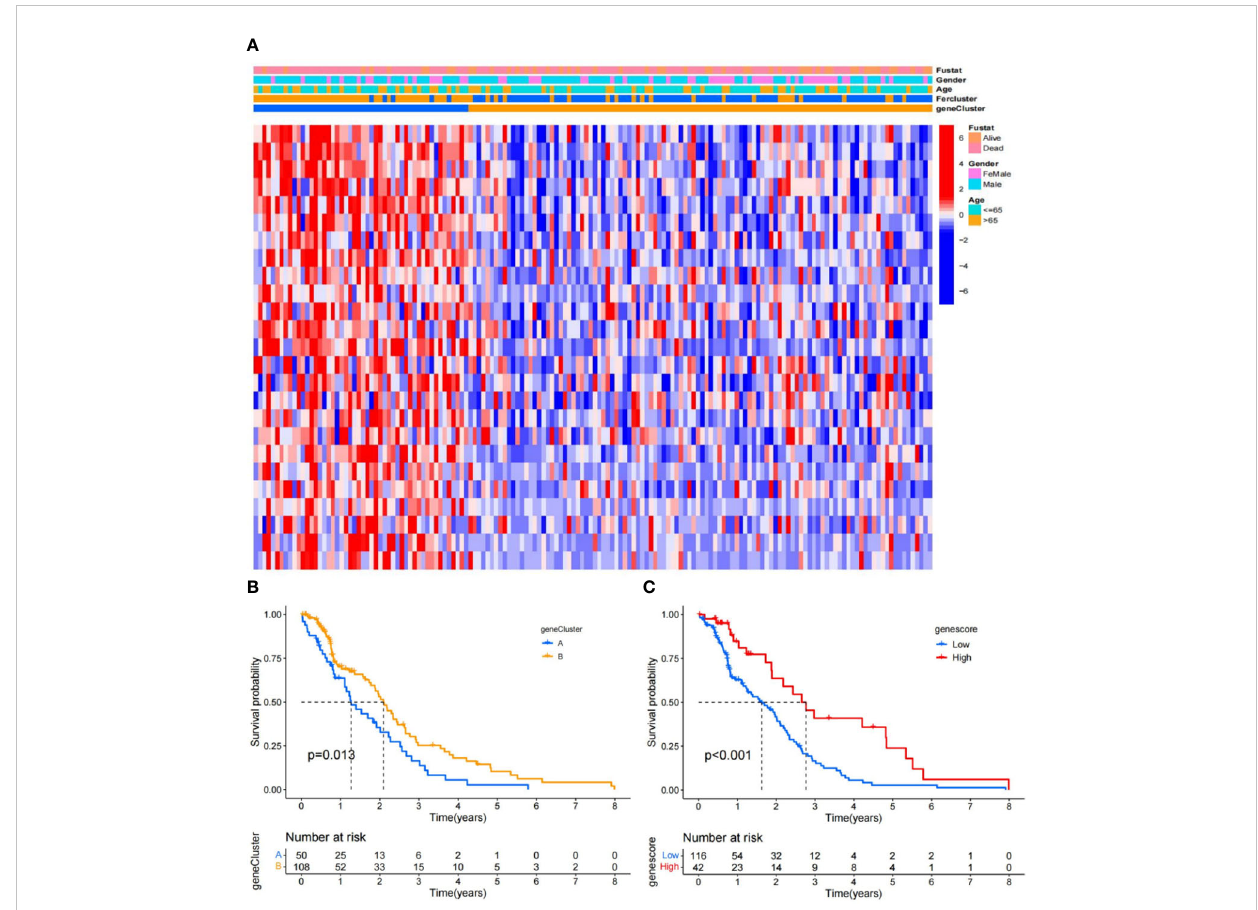
FIGURE 3 Ferroptosis signatures. (A) Unsupervised clustering of overlapping ferroptosis-related genes in the TCGA-GBM cohorts to classify cases, termed as gene clusters A and B, respectively. The gene clusters, PCA scores, and age were applied as patient annotations. (B) KM curves of the gene clusters. (C) KM curves of the gene scores in the